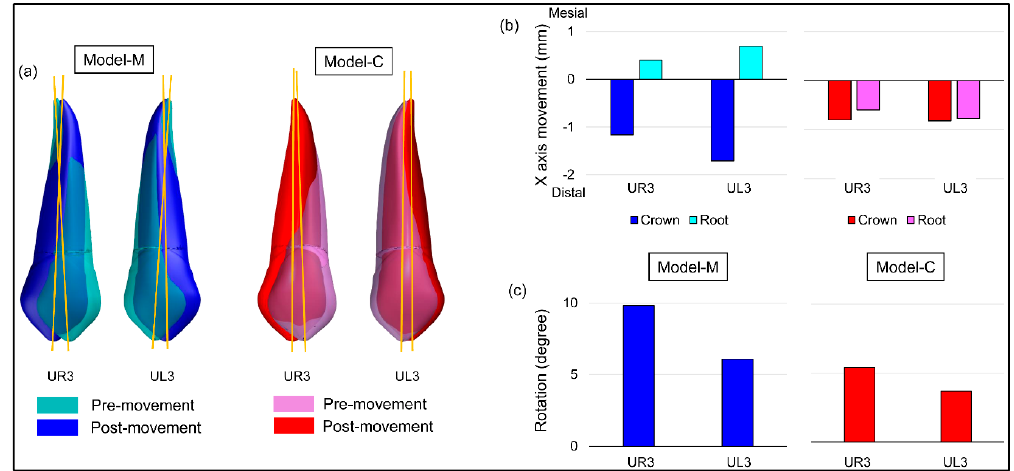
Figure 10. Results of tooth movement with magnetic force. ( a ) Images of maxillary right canine (UR3) and maxillary left canine (UL3) of pre ‐ and post ‐ movement, ( b ) distance moved on crown and root apex, ( c ) mesial tooth rotation.